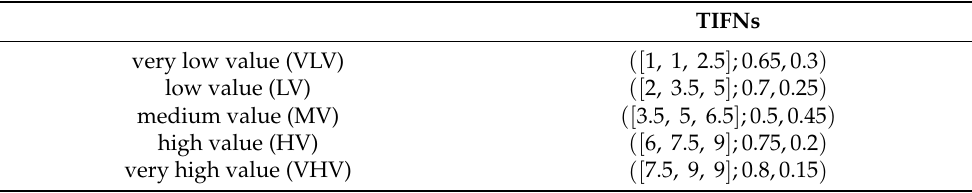
Table 2. The RF values and degree of belief that quality methods are applicable.